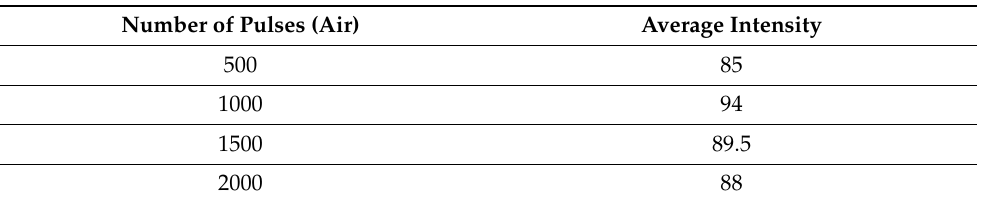
Table 3. The variation in the average peak intensity of IR spectra, at constant fluence value